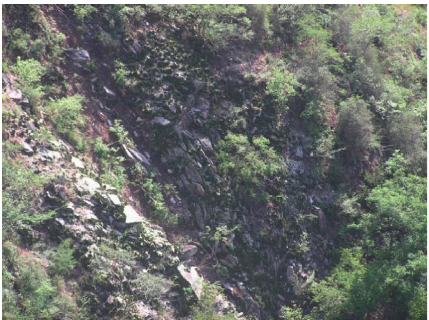
Figure 7: Material composition of the sliding mass in partition